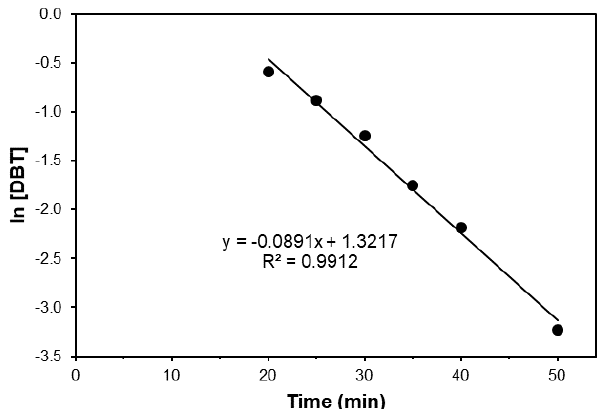
Figure 7. First-order plot after induction period for aerobic oxidation of DBT (0.50 mmol) in the presence of PhCHO (4.9 mmol) catalyzed by HPA-1 (0.10 g, 0.048 mmol) at 100 ◦ C, 10 mL dodecane, 20 mL min − 1 air flow and 1300 rpm stirring speed; k DBT = 0.089 min − 1